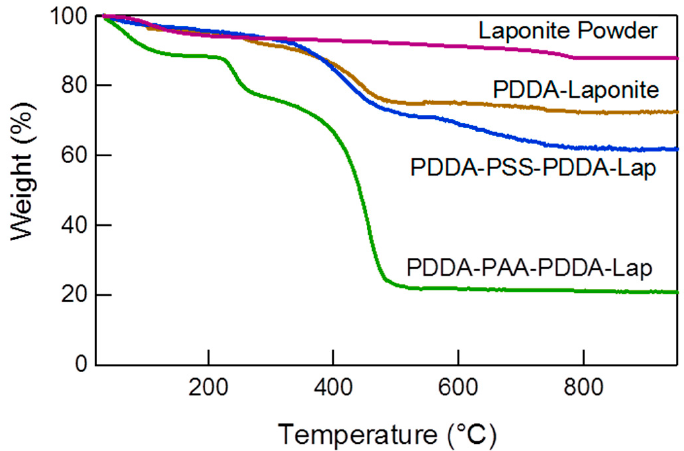
Figure 1. SEM cross-section images of 140-layer films of ( a ) PDDA-Laponite, ( b ) PDDA-PSS-PDDA- Laponite, and ( c ) PDDA-PAA-PDDA-Laponite. Lines with arrows indicate the thickness of the film deposited on the substrate. ( d ) Film thickness as a function of the number of layers for the three systems.